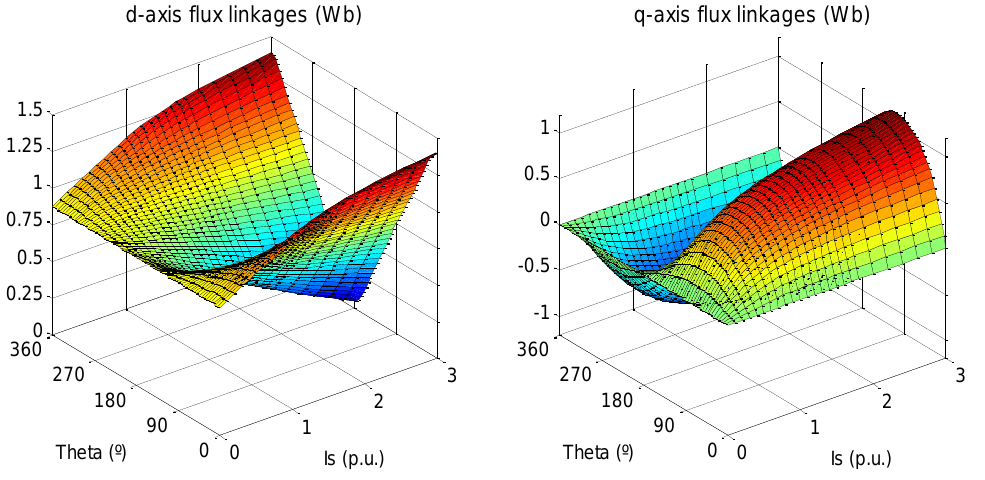
Figure 5. Interior PMSM LUTs relating stator current and flux linkages (simulation